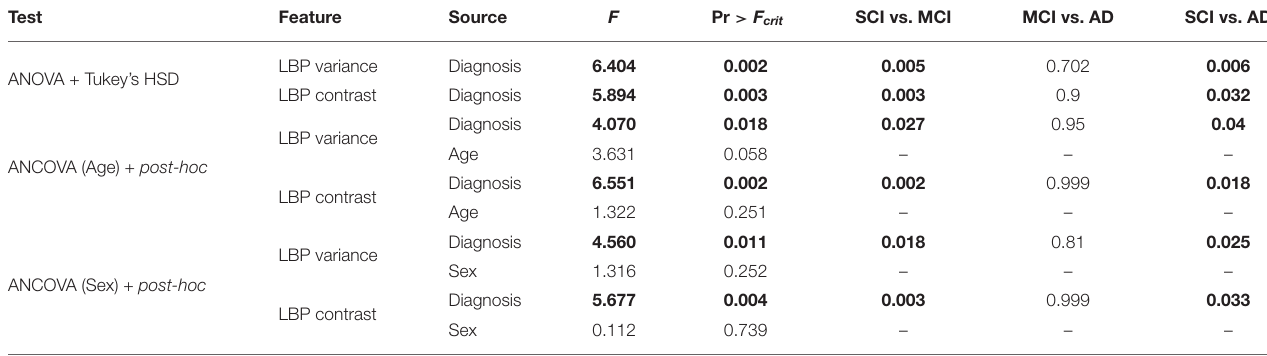
TABLE 5 | One-way ANOVA and ANCOVA tests with post-hoc analysis for each asymmetry biomarker.